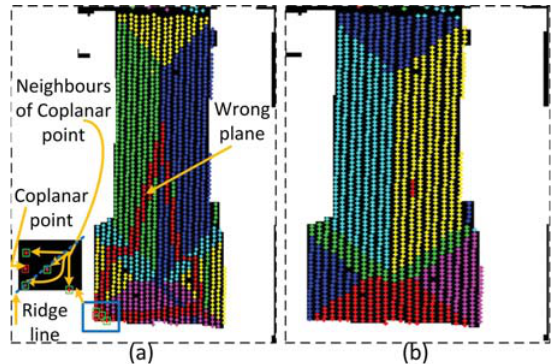
Figure 3: Planar segments from Cluster 1 in Figure 2d: (a) ex- tracted and (b)